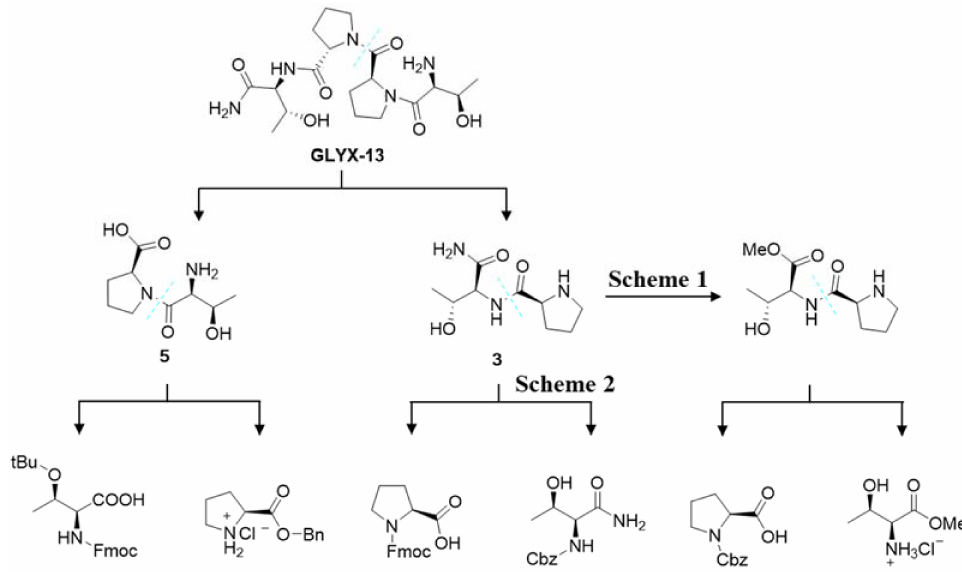
Figure 1. Retrosynthesis of GLYX-13.